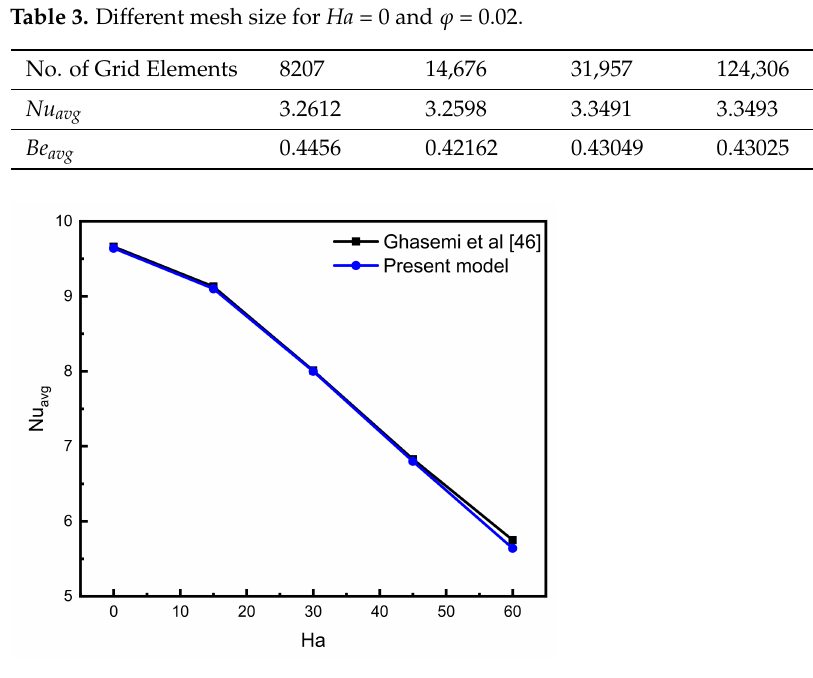
Figure 2. Comparisons of present model with previous works